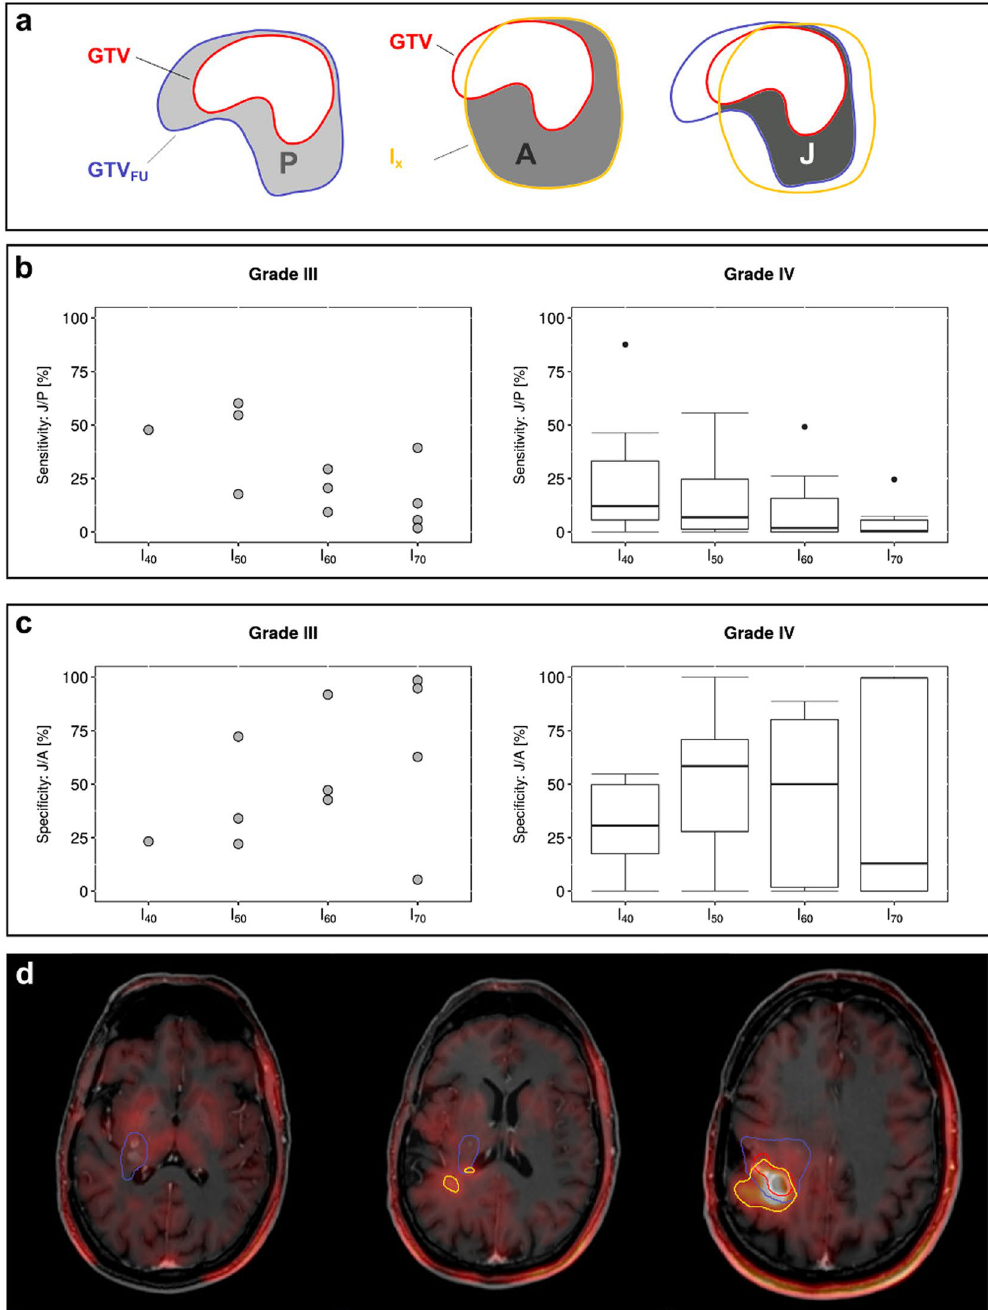
Figure 4. Detection of potential tumor progression by 18 F-FET PET. The progressive tumor volume P was assessed by contouring the progressed tumor GTV FU on the follow-up T 1 CE MRI and calculating the difference to the original GTV: P = GTV\GTV FU . Of the 16 patients investigated, only n = 3 patients showed an in-field progression pattern. Therefore, the predominant failure pattern was “marginal” with 83% of patients (n = 12 patients) developing recurrences at the edges of the carbon ion field (CTV) underscoring the need for better delineation of the target volume. To evaluate, whether the PET isocontour volume A = I x \GTV outside of GTV could indicate parts of the progressed tumor volume, the intersection J between A and P was calculated with J = A\P, as schematically shown in ( a ). The sensitivity ( b ), percentage of progressive tumor volume that is covered by the additional PET active volume (J/P), and specificity ( c ), percentage of 18 F-FET PET active volume that includes areas of tumor progression (J/A), of the additional 18 F-FET active volume to detect regions at risk for tumor progress are shown. In grade III glioma, sensitivity decreases with increasing isocontour thresholds, whereas specificity increases with increasing isocontour thresholds. In grade IV glioma sensitivity decreased with increasing isocontour thresholds. Images in ( d ) show three axial slices in an example patient (grade IV) with low sensitivity and specificity, i.e. little overlap between 18 F-FET PET (yellow line) and progress (blue